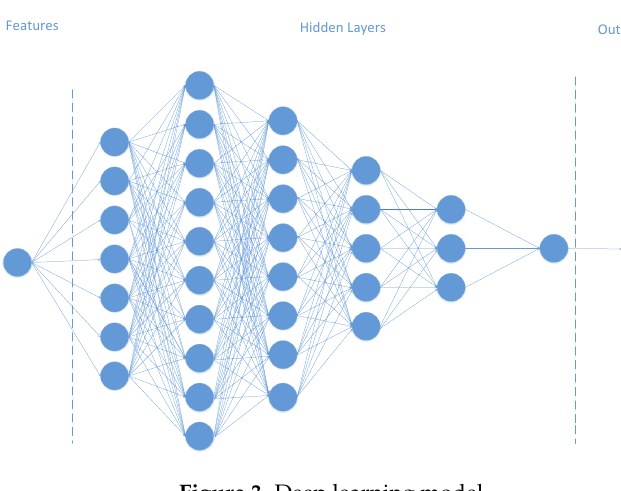
Figure 3. Deep learning